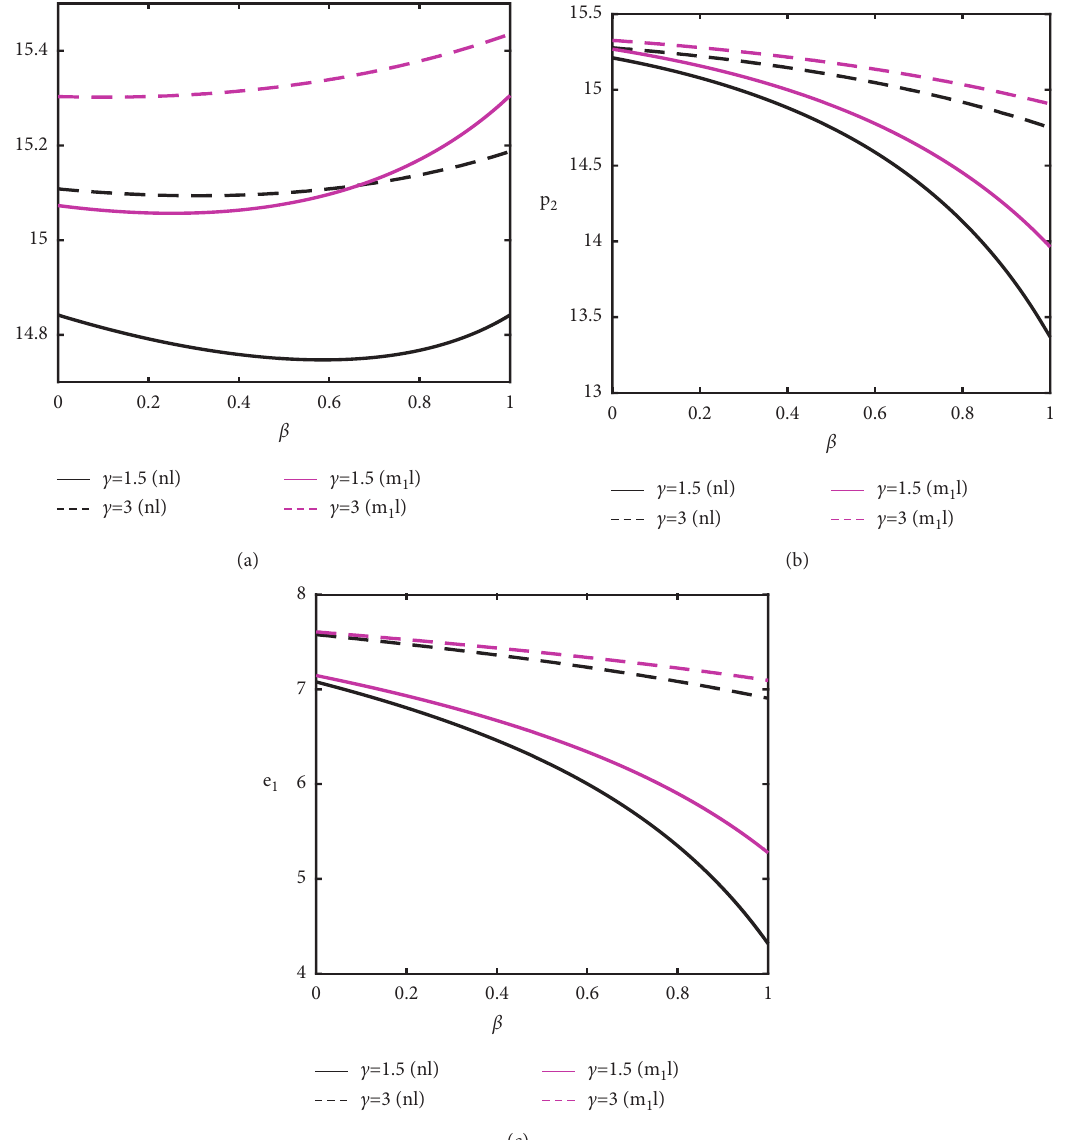
Figure 1: The impact of β and c on price and e and c on e 1